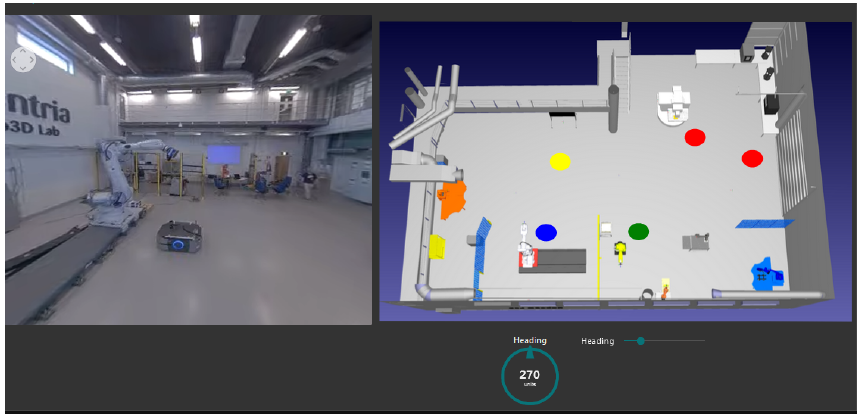
Figure 6. Control interface of mobile robot with embedded live video